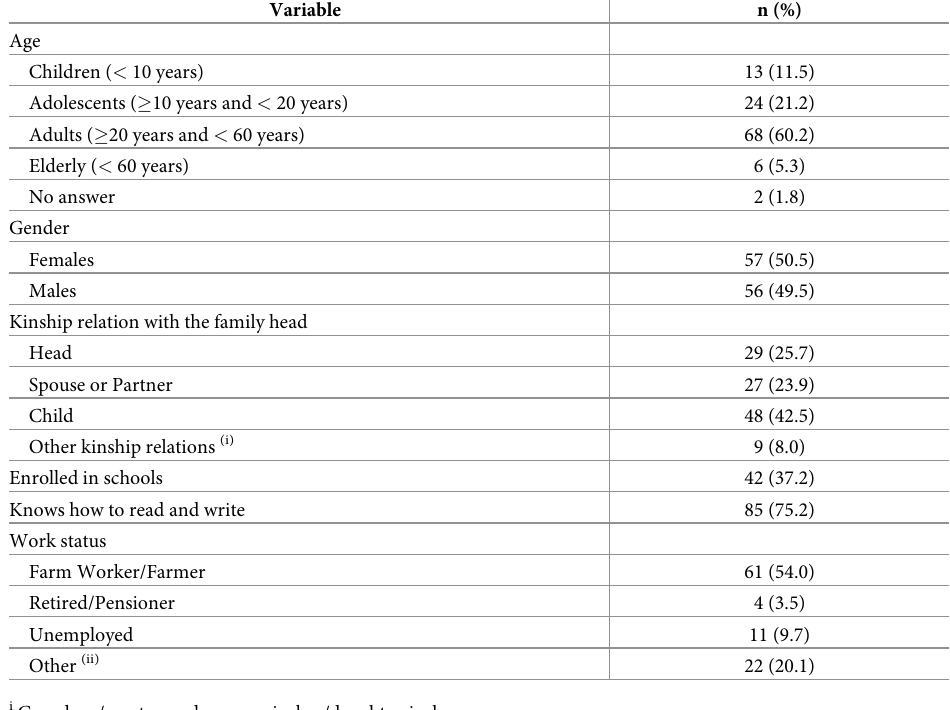
Table 1. Socio-demographic characteristics of the population in the semi-arid region of Alagoas, Brazil, 2016 (n =